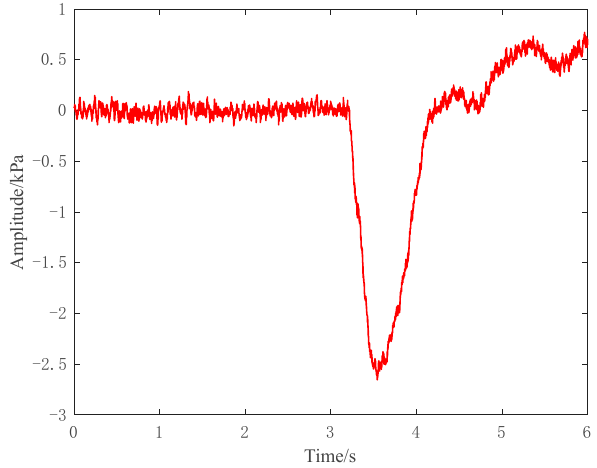
Figure 10. Signal curve after denoising by the IUPLCD method.